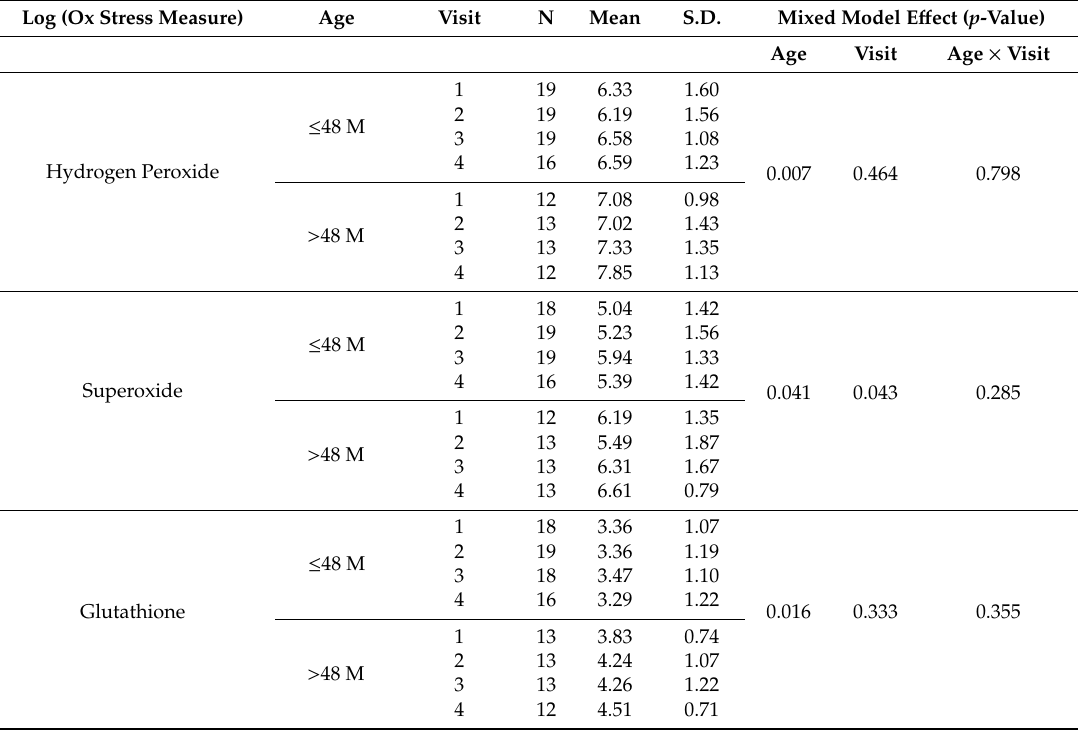
measured by hydroethidine (HE) fluorescence, and ( c ) glutathione measured by monochlorobimane (mBCI) fluorescence. Mean fluorescent intensity (MFI) for each of these dyes is shown on the y axis of each graph. Peripheral blood samples from pediatric cancer patients and survivor participants were used. Mononuclear cells were isolated to conduct measurements of oxidative stress. Intracellular levels of free radicals were assessed using flow cytometry. Levels of the most abundant cellular antioxidants in mononuclear cells were determined using fluorometric and photometric assays. Normalized (log-transformed) data by age group and visit is shown in Table 2. Significance of associations is marked with * ( p < 0.05) or ** ( p < 0.01). Table 2. Oxidative Stress Measures Over Time by Age Group and Visit. Log (Ox Stress Measure) Age Visit